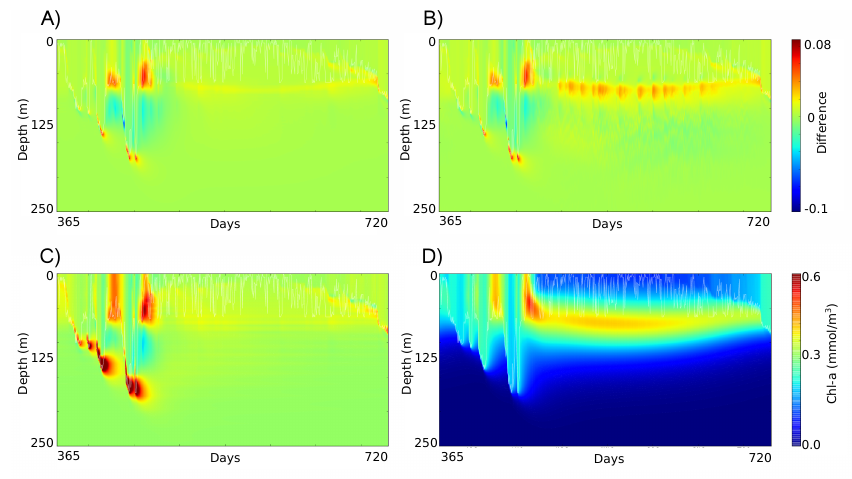
Fig. 18. Difference plots of chlorophyll at Bermuda comparing adaptive simulations (A and B) and a fixed, but varying resolution mesh (C) to the highest resolution (2.5m) uniform mesh simulation (D) . A clear improvement can be made in the subsurface chlorophyll maximum representation by adding chlorophyll to the adaptivity metric. (A) The original adaptive mesh simulation shows larger discrepancies around the subsurface maximum (B) . Using fixed variable resolution as in other ocean models shows clear discrepancies in the spring and throughout the summer (C)